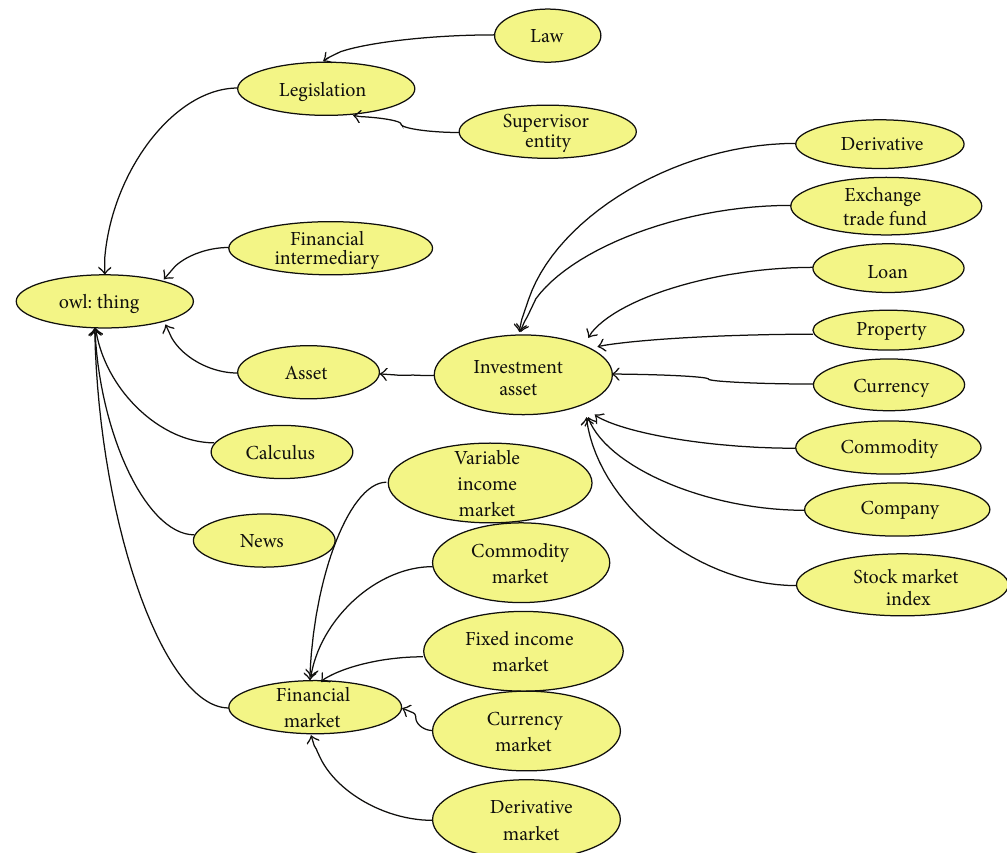
Figure 7: Excerpt of the financial